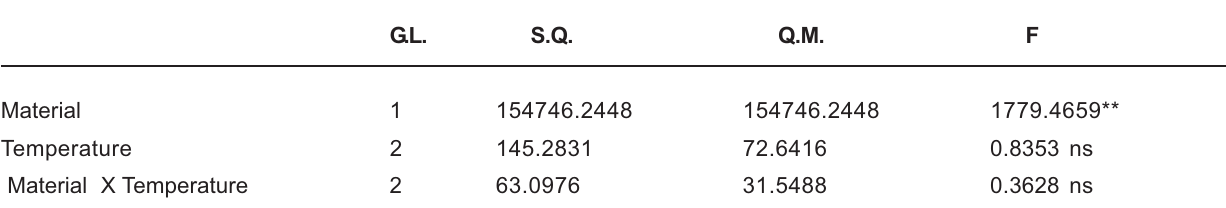
TABLE 4- Analysis of variance for Vickers hardness between material and